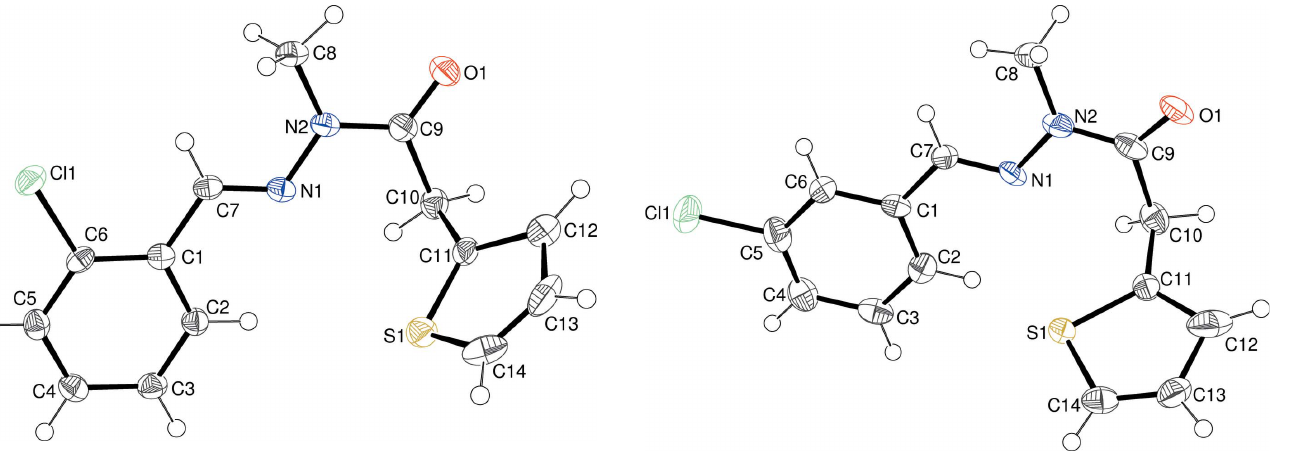
Figure 1 The molecular structure of (I), showing 50% probability displacement ellipsoids. Only the major orientation of the thiophene ring is